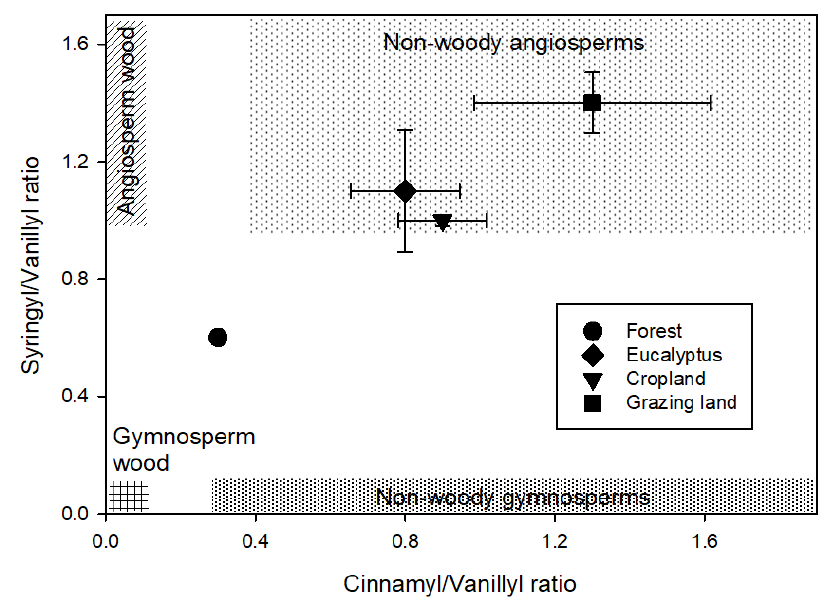
Figure 2. Lignin source parameters of the monomeric syringyl/vanillyl (S/V) and cinnamyl/vanillyl (C/V) phenol ratios among four land-use systems at Gelawdios, Ethiopia. Patterned areas indicate the expected S/V to C/V relationships of four vegetation types according to Reference [35]. Shown